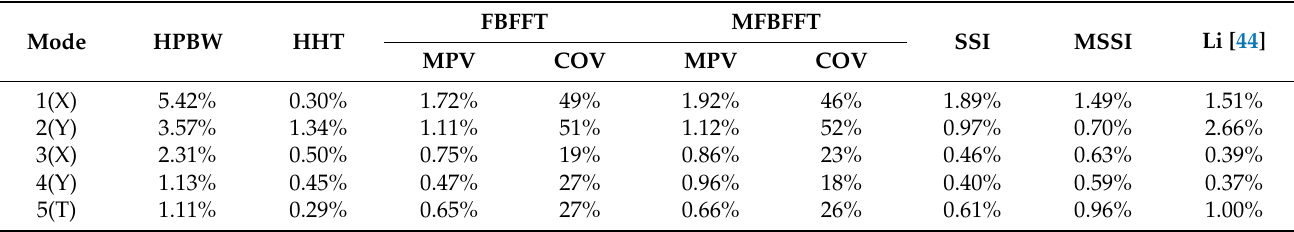
Table 7. Identified frequencies under earthquake of the Canton Tower. Table 8. Identified damping ratios under earthquake of the Canton